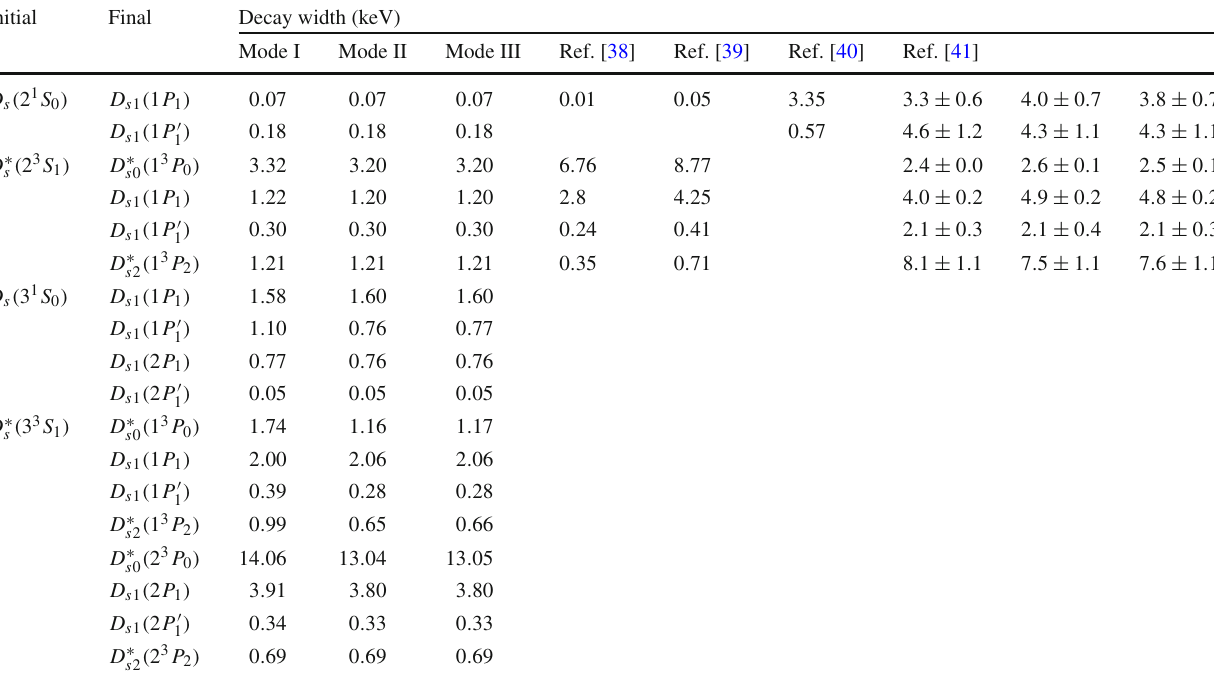
Table3 Electrictransitionwidthsfor S → P γ processes,where P and S are P - and S -wave charmed-strange mesons, respectively. For com- parison, we also present the theoretical estimations from Refs. [38–41].